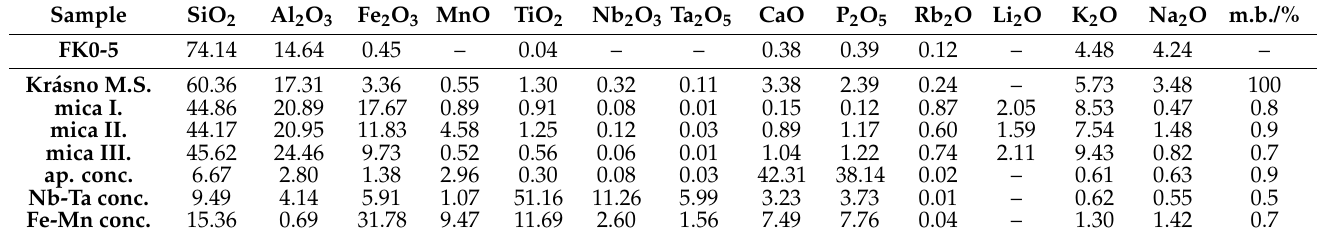
Table 1. Results of XRF analyses of respective fractions obtained during laboratory separation of Kr á sno feldspar ore (data in wt.%) and their mass balance (m.b.) as a percentage of input material (Kr á sno M.S.). Li 2 O analyses (performed on mica samples only) was performed by AAS (Atomic absorption spectroscopy) method (VARIAN type SpectrAA 280 FS, Agilent, Santa Clara, USA). Typical composition (average value from analyses routinely performed on daily production during last 2 years) of the most common product (FK0-5) is provided for comparison. Note that topaz fraction was not analysed due to its very low content (about